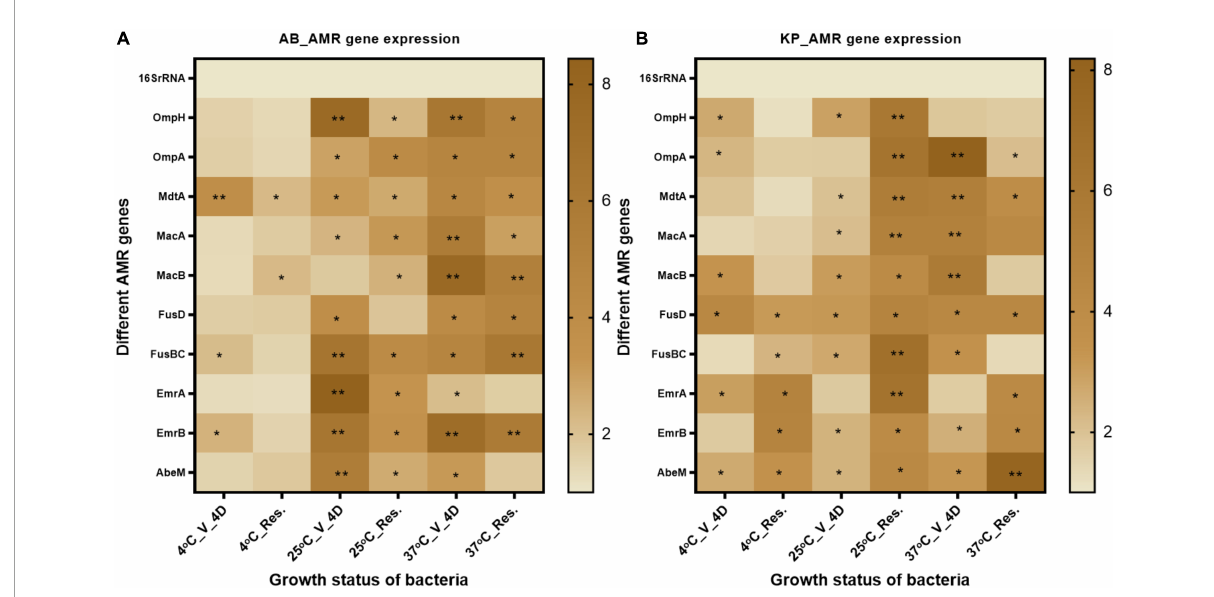
FIGURE7 AMR gene expression- Efflux pump and outer membrane proteins related to gene expression were checked after 4-day formic acid (FA) induced VBNC and resuscitated bacteria. (A) The expression pattern in Acinetobacter baumannii , and (B) expression pattern in Klebsiella pneumoniae . Efflux pump genes related to the antibiotics in VBNC as well as in resuscitated cells at 25 and 37 ◦ C (4 days) were increased up to 10-fold. While almost 2–4-fold expression was observed in VBNC and resuscitated cells incubated at 4 ◦ C. The statistical significance of fold change was determined by two-way ANOVA with multiple comparison followed by correction with Dunnett’s multiple comparison test using GraphPad Prism version 9.0.0. V, VBNC; Res, resuscitated; 4C_V_4D, day 4 VBNC at 4 ◦ C and FA; 25C_V_4D, day 4 VBNC at 25 ◦ C and FA; 37C_V_4D, day 4 VBNC at 37 ◦ C and FA; 4C_Res_4D, day 4 resuscitated from 4 ◦ C and FA induced VBNC; 25C_Res_4D, day 4 resuscitated from 25 ◦ C and FA induced VBNC; 37C_Res_4D, day 4 resuscitated from 37 ◦ C and FA induced VBNC; 4C_V_10D, day 10 VBNC at 4 ◦ C and FA; 25C_V_10D, day 10 VBNC at 25 ◦ C and FA; 37C_V_10D, day 10 VBNC at 37 ◦ C and FA. * P -valve < 0.5, ** P -valve <